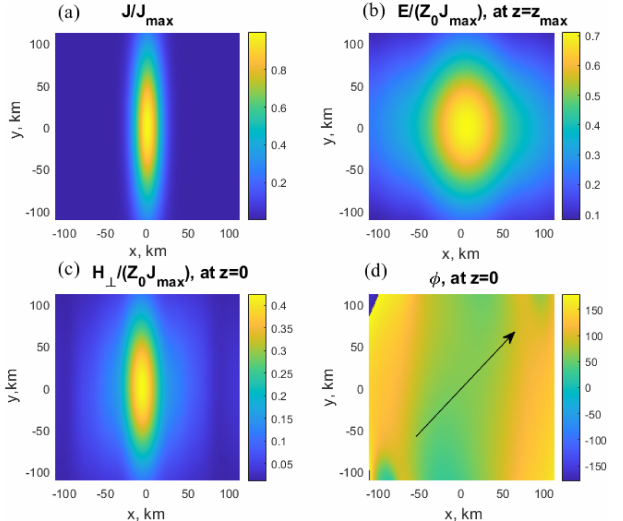
Figure 3. Altitude dependences of the amplitudes of horizontal electric and magnetic fields.